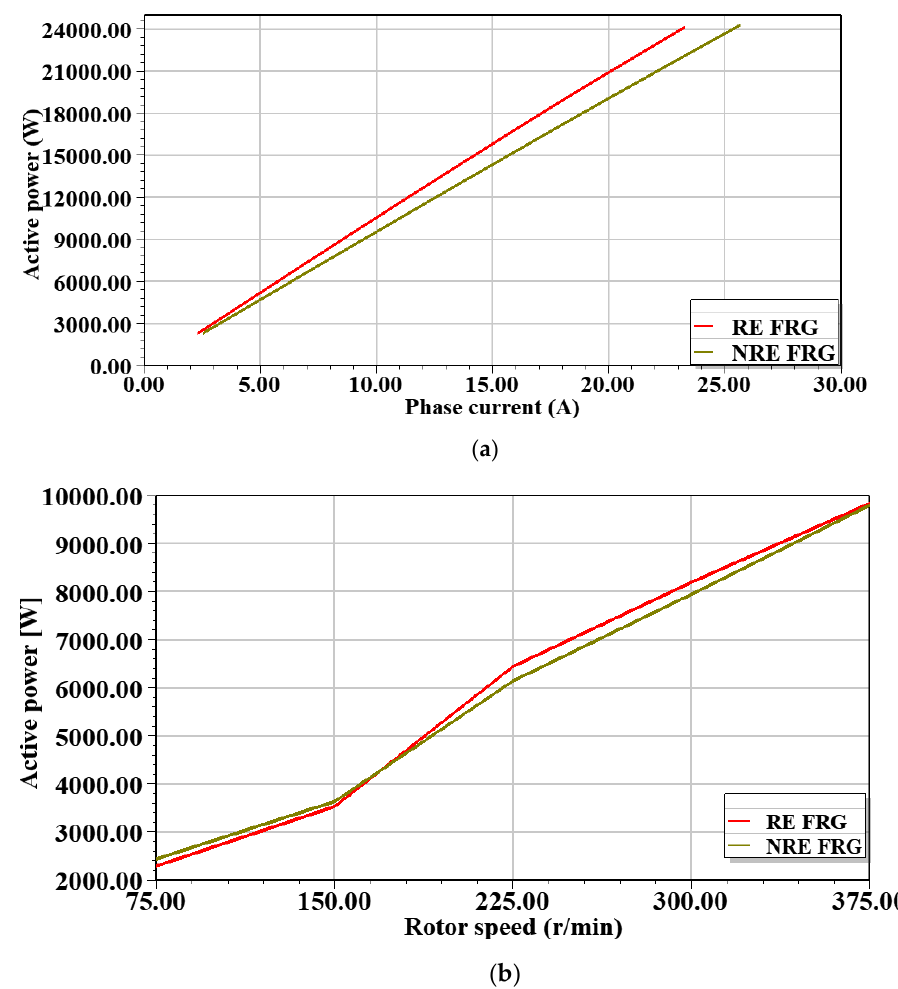
Figure 6. Rated load flux density plot of 10 kW FRGs: ( a ) RE-FRG and ( b ) NRE-FRG.